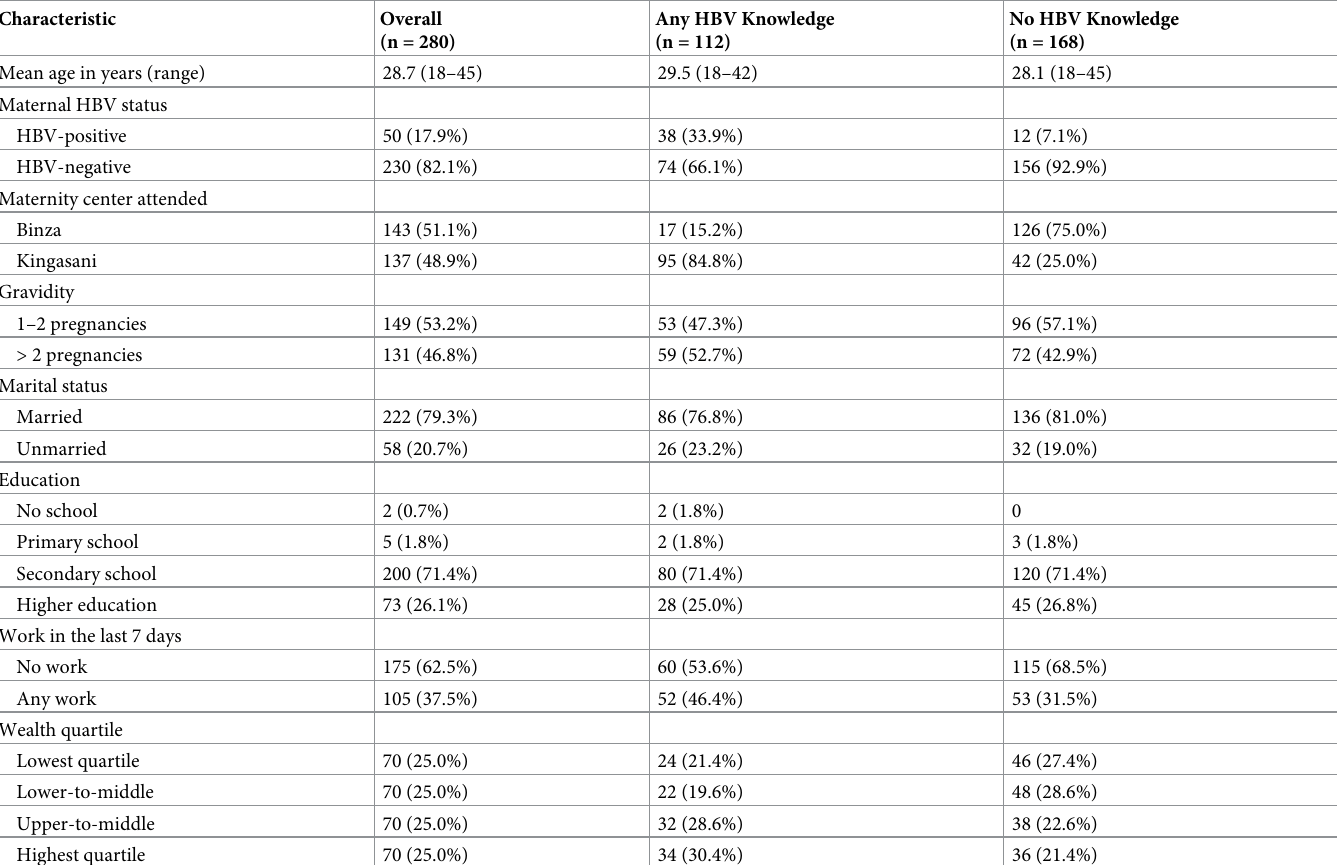
Table 1. Demographic characteristics of enrolled women in the overall cohort and stratified by HBV knowledge category. Participants in the “any HBV knowledge” category scored > 0 on the HBV knowledge assessment and participants in the “no HBV knowledge” category scored 0 points on the HBV knowledge assessment.